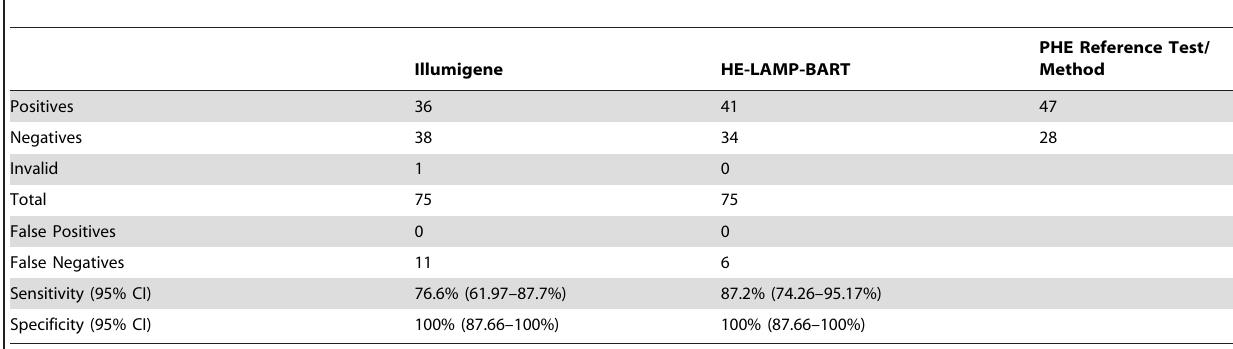
Table 5. Comparison of HE-LAMP-BART and the Illumigene LAMP Methods against the reference method.